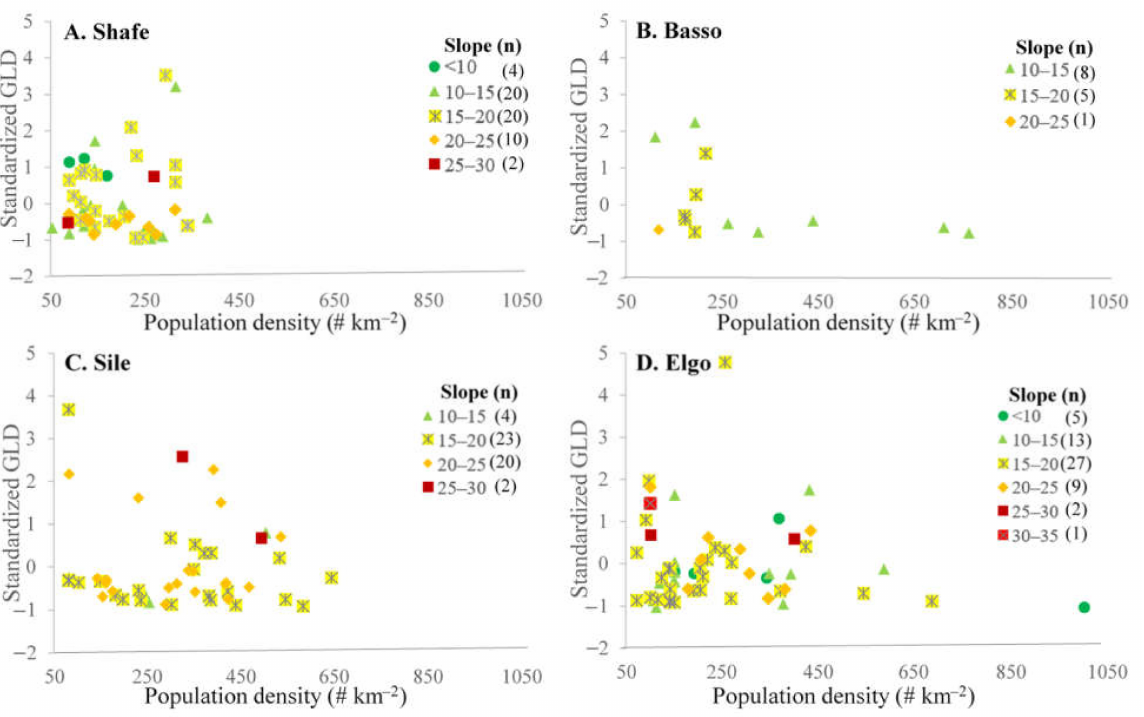
Figure A4. Relationships between population density for the year 2020 and GLD, for active gullies of each river catchment. Slope represents the mean slope angle (degree) of each sub-catchment and n represents the number of sub-catchments of each slope-angle